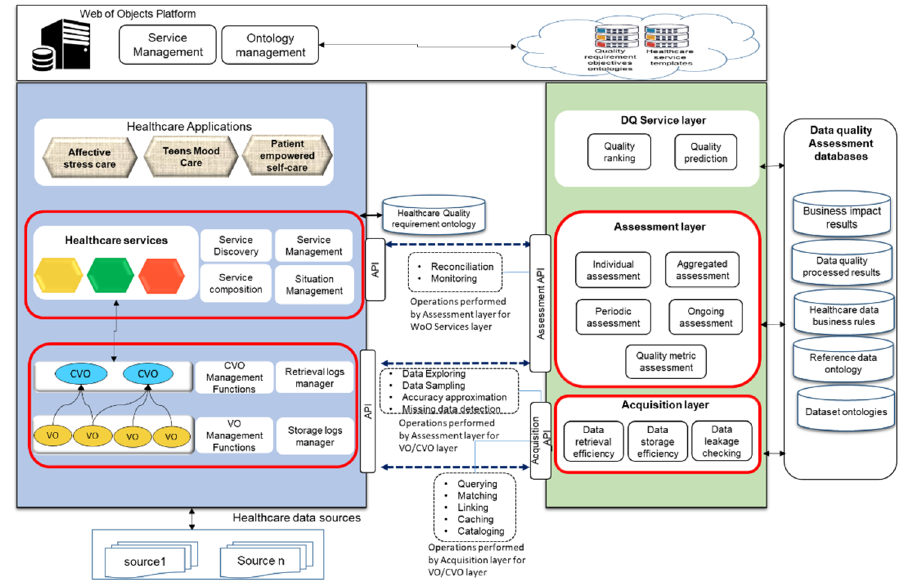
Figure 8. Web objects based data quality assessment model for semantic data application.